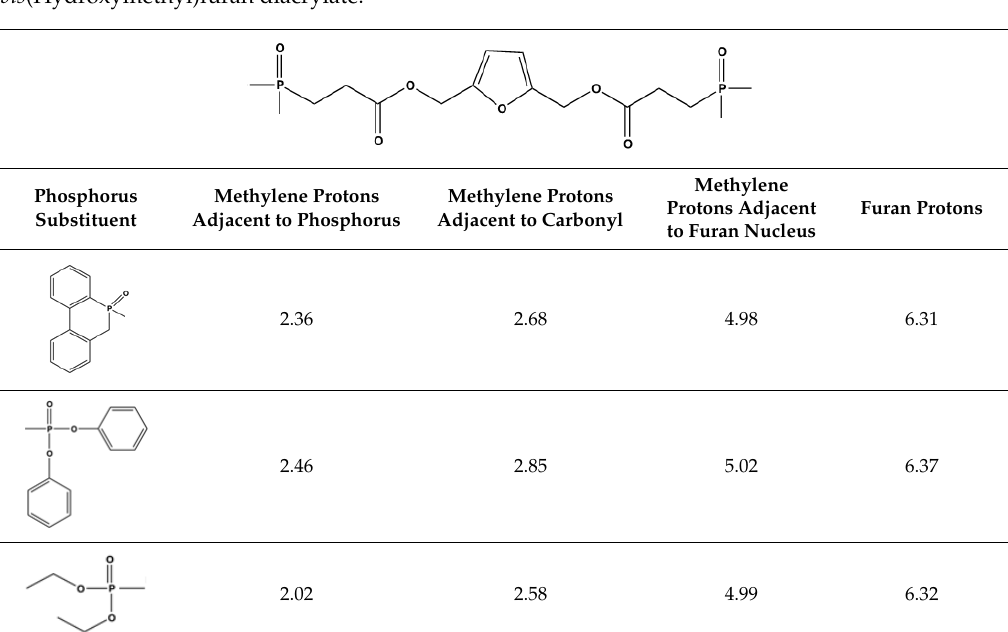
Table 2. Characteristic 1 H-NMR chemical shifts for phosphorus derivatives of 2,5- bis (Hydroxymethyl)furan diacrylate. a